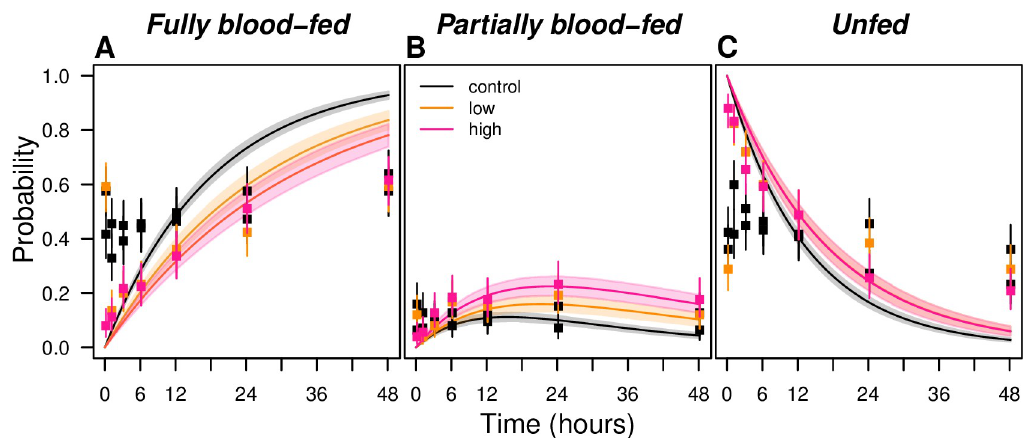
Fig 2. Effect estimates of an experimental SR product containing transfluthrin on the probability of blood feeding over time. (A) fully blood-fed, (B) partially blood-fed, and (C) unfed Aedes aegypti mosquitoes. Squares denote the observed data for control (black), low (orange), and high dosage regimen (pink). High and low dosage estimatesin C overlap.Bars denote the corresponding binomial 95%-confidence intervals.The shaded areas denote the 2.5th and 97.5th percentile of the model estimates